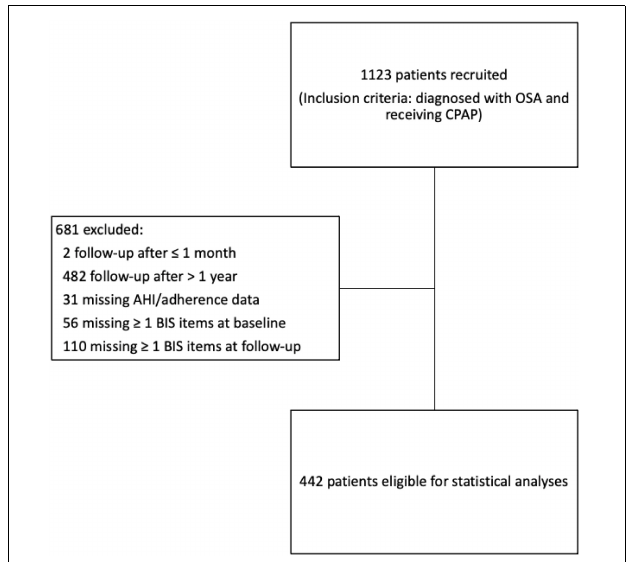
FIGURE 1 | Overview of the participants in the